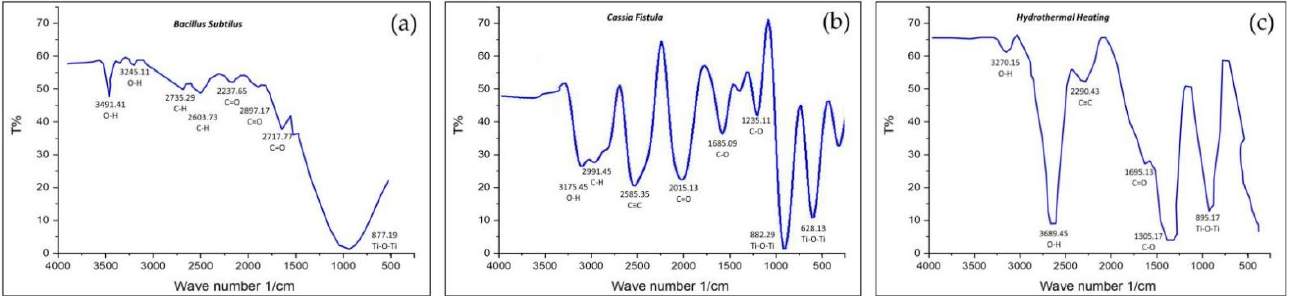
Figure 10. FTIR images of different sizes of TiO 2 NPs attained from ( a ) Bacillus subtilis [79], ( b ) Cassia fistula , and ( c ) hydrothermal heating [80]. fistula , and ( c ) hydrothermal heating